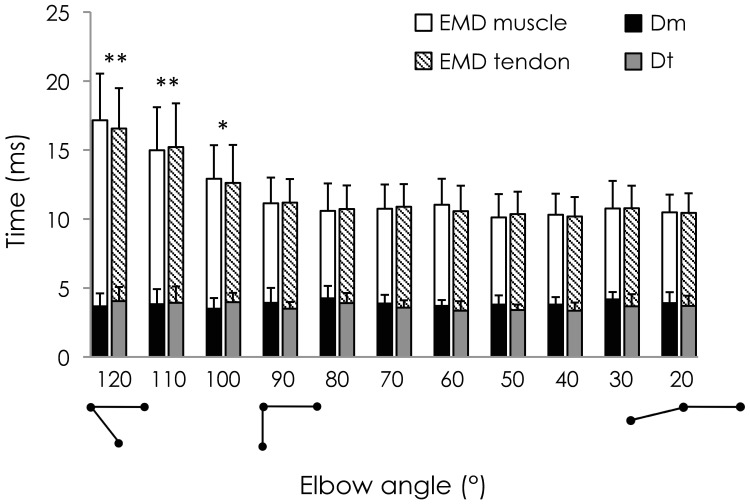
Effect of elbow joint angle on EMD, Dm, and Dt.For each angle, electromechanical delay (EMD), the onset of muscle fascicle motion (Dm) and the onset of myotendinous junction motion (Dt) were determined during an electrically evoked contraction. Two histograms are depicted for each angle (for muscle trials and for tendon trials). EMD for muscle and tendon trials is represented by the addition of filled and open bars (muscle trials) and filled and hatched bars (tendon trials). Dm and Dt are symbolized by the filled bars in black and grey, respectively. *: p<0.05 and **: p<0.001: Significant difference in EMD from the elbow joint angle of 90°.